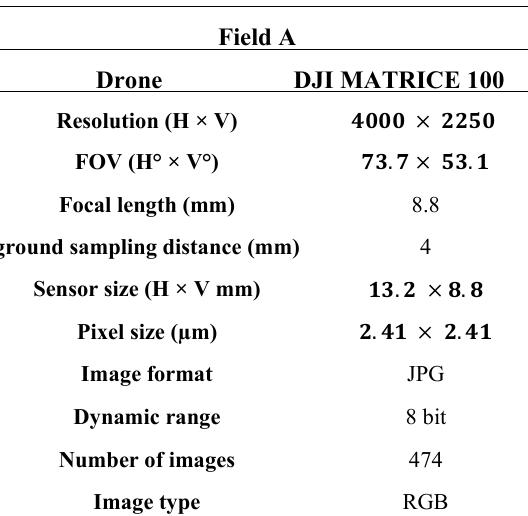
Table 1. Unmanned aerial vehicle (UAV) sensor and image parameters of the field A database